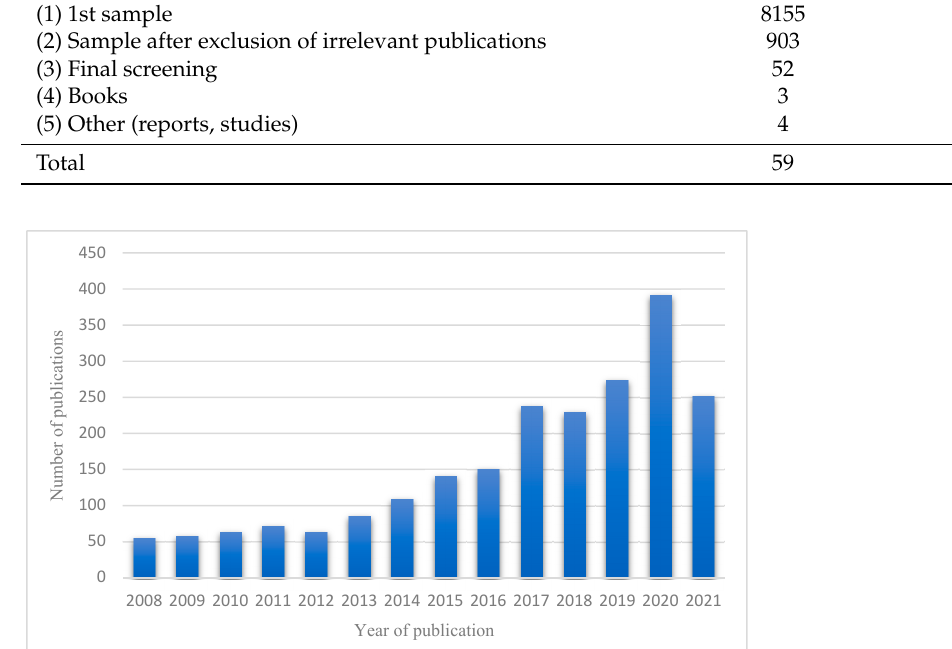
Figure 3. Statistical analysis of articles related to the topic of “slow pyrolysis of agricultural and agro-industrial waste”.